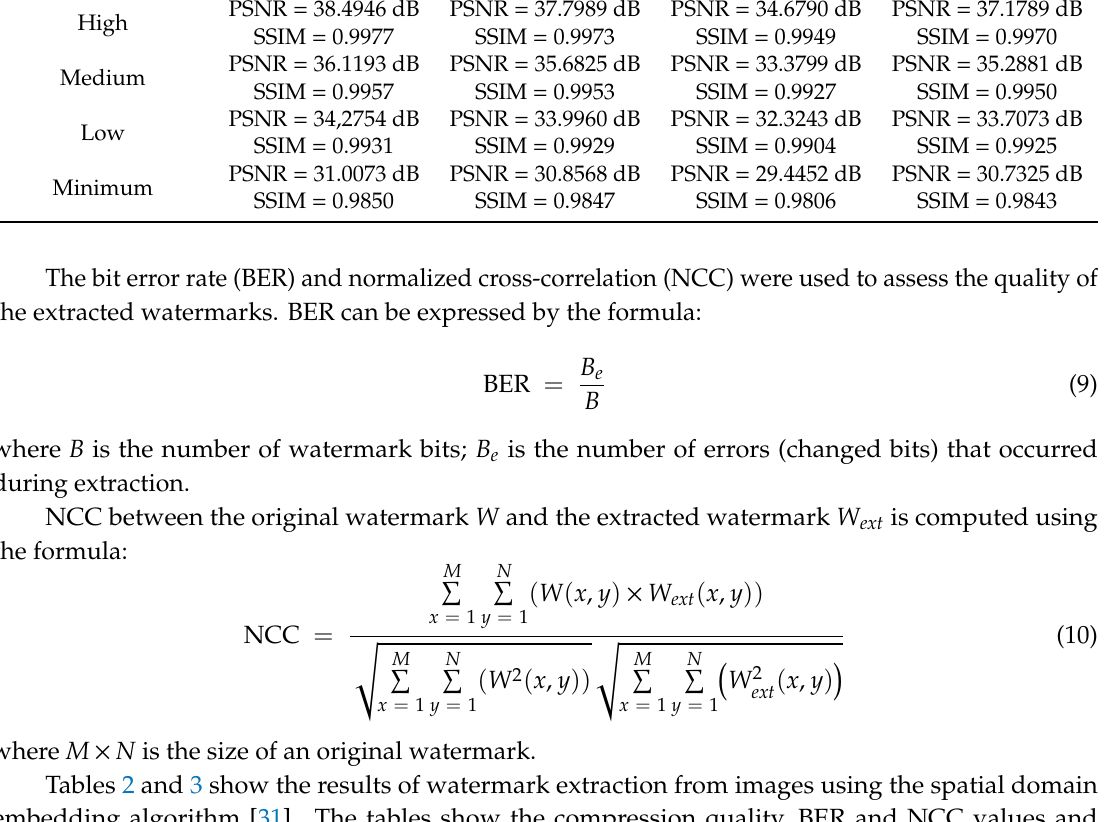
Table 1. Compressed images quality metrics.